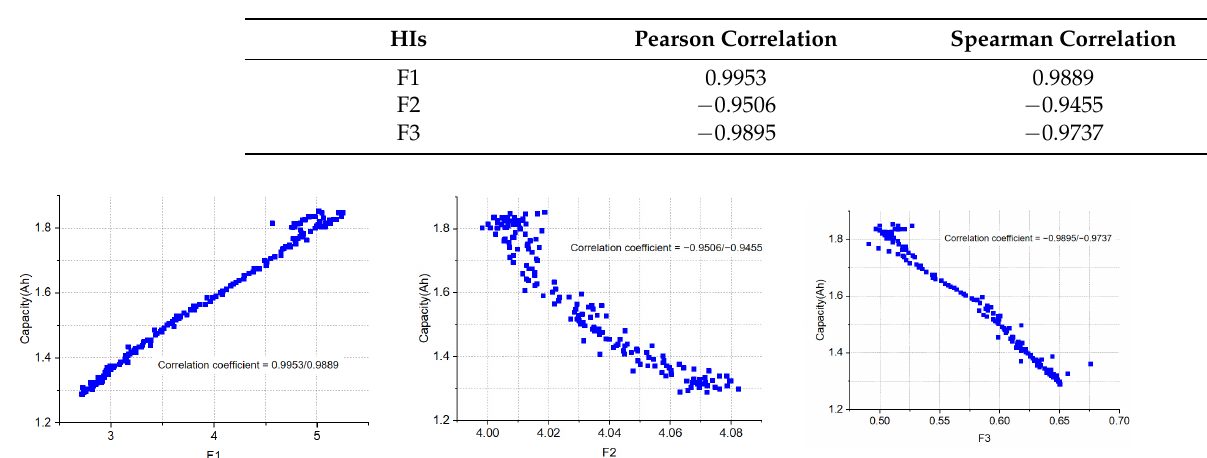
Figure 6. Relationship of HIs and the reference capacity of B05.